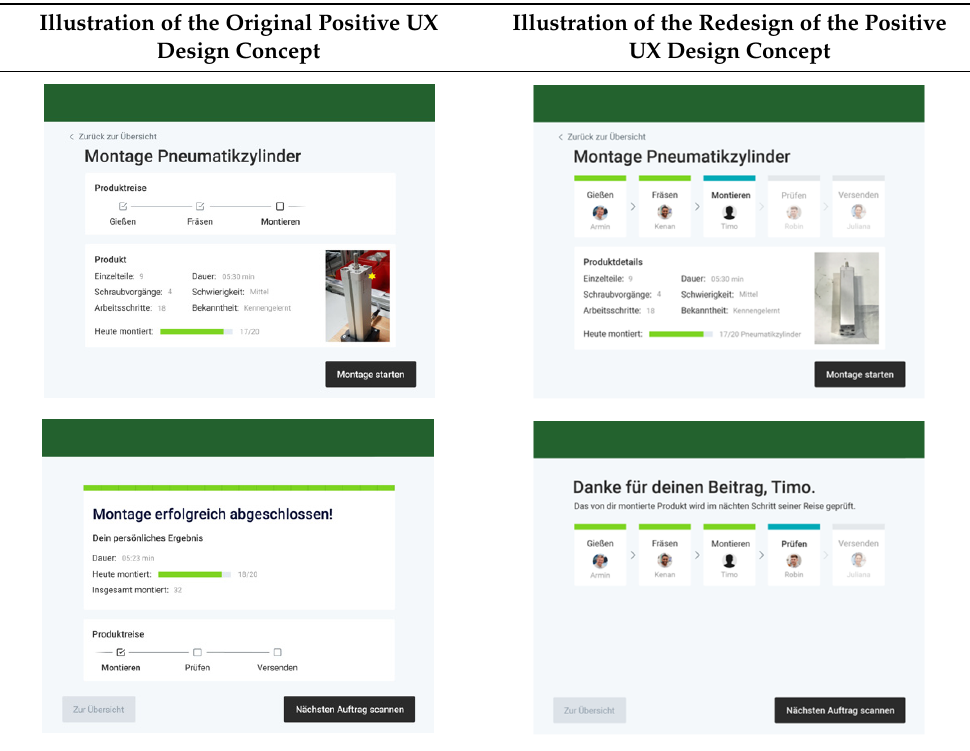
Table 5. Original positive UX design concept and respective redesign of “Product journey”.